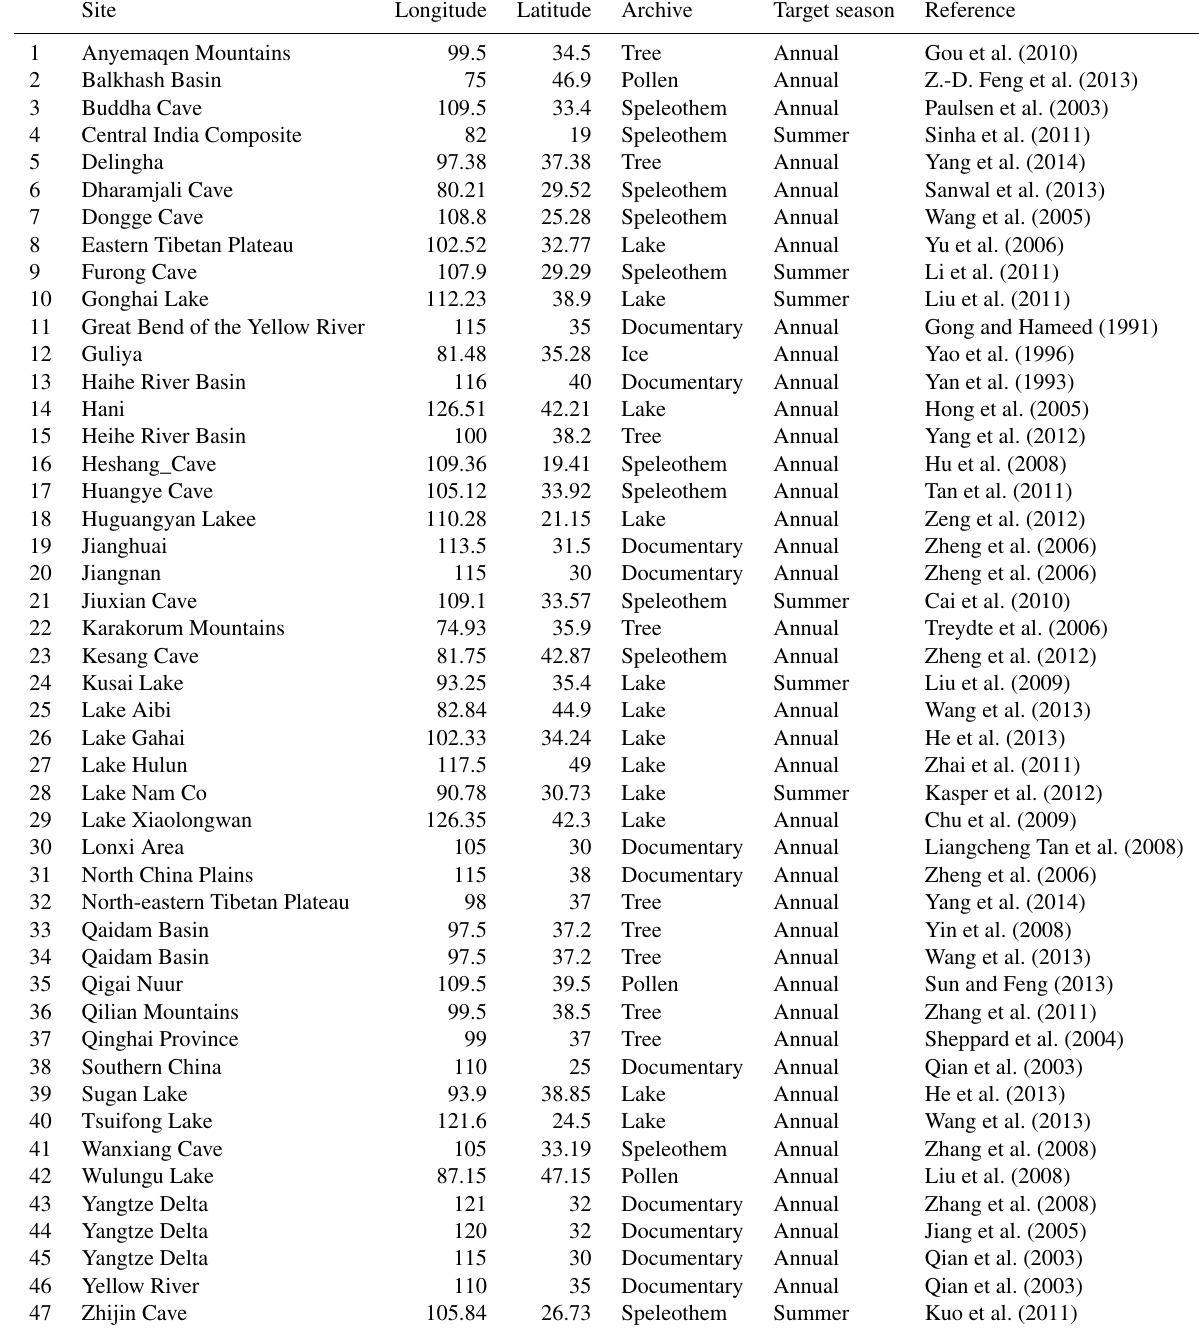
Table 1. List of the real-world proxy records used to select the locations of the pseudo-proxy